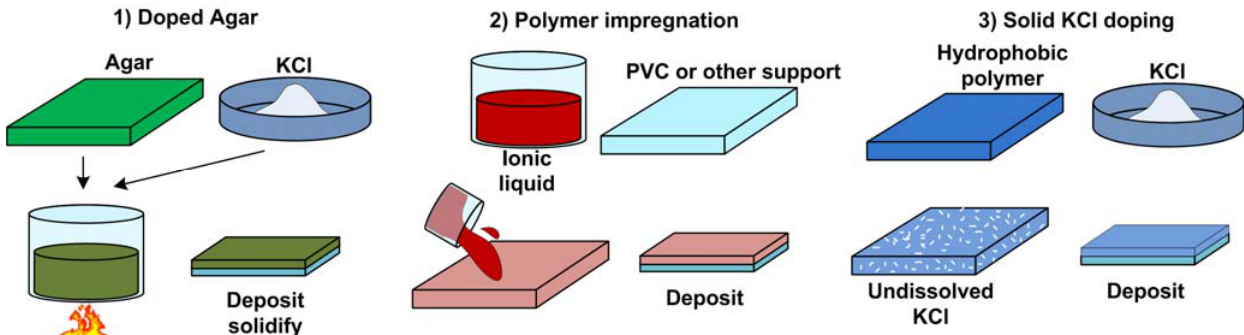
Figure 7. Different methods for synthesis of a solid-state membrane